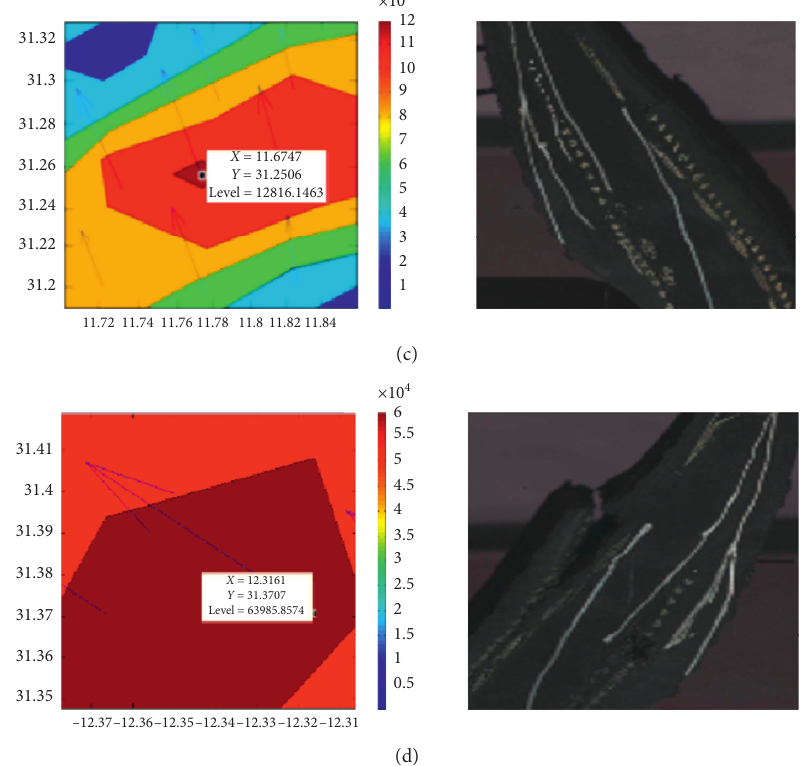
Figure 6: SEDG 2D vector of each part. (a) Left tire shoulder. (b) Right tire shoulder. (c) Left bead area. (d) Right bead area.